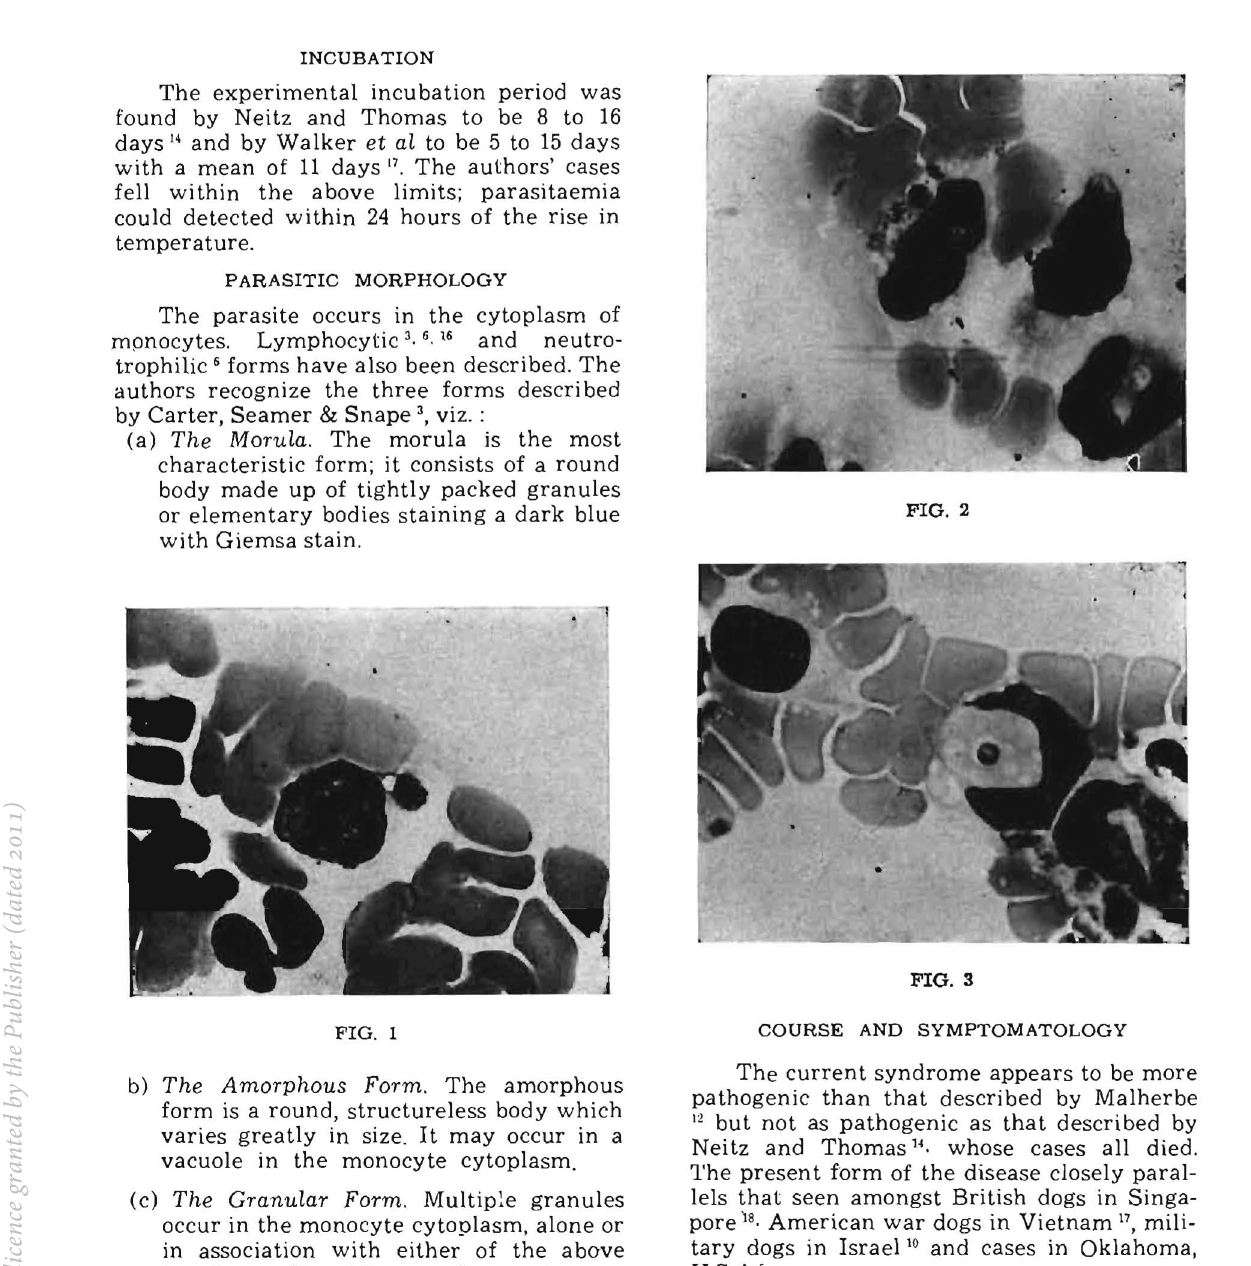
Fig. 1: A morula form of E. canis in monocyte cytoplasm. Fig. 2: An amorphous form of E. canis with multiple granules in monocyte cytoplasm. Fig. 3: An amorphous form of E. canis within a vacuole in monocyte